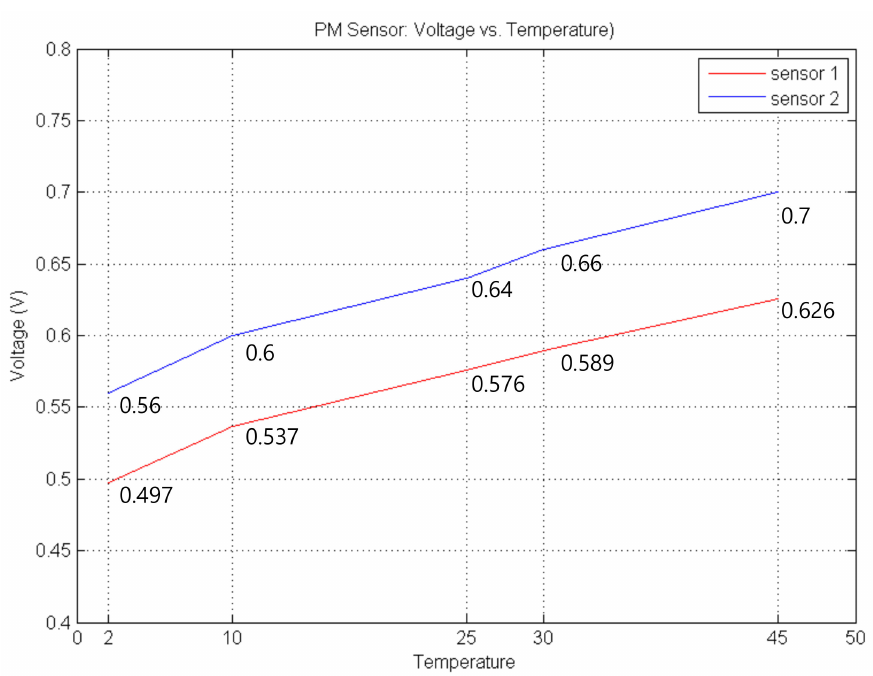
Figure 10. Offset according to ambient